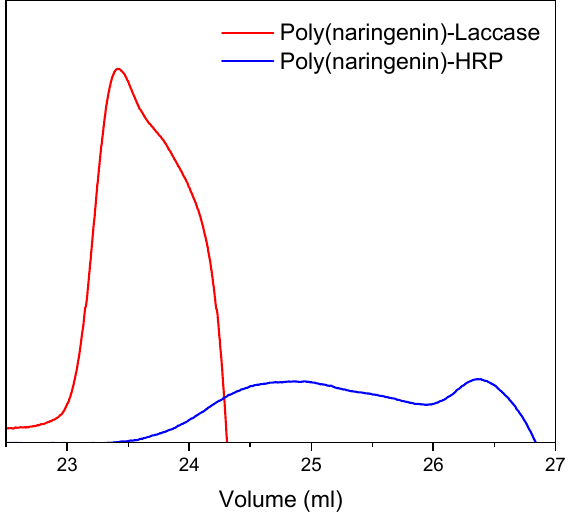
Figure 4. Gel permeation chromatography GPC traces of poly(naringenin)-laccase and poly(naringenin)-HRP samples.